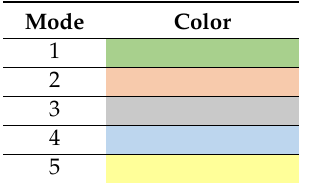
Figure 11. Shakedown Testing: ( Top ) System demand on the heater, thermocline, and total system. ( Bottom ) Thermocline fluid temperature at various points within the tank. Table 6. Mode color